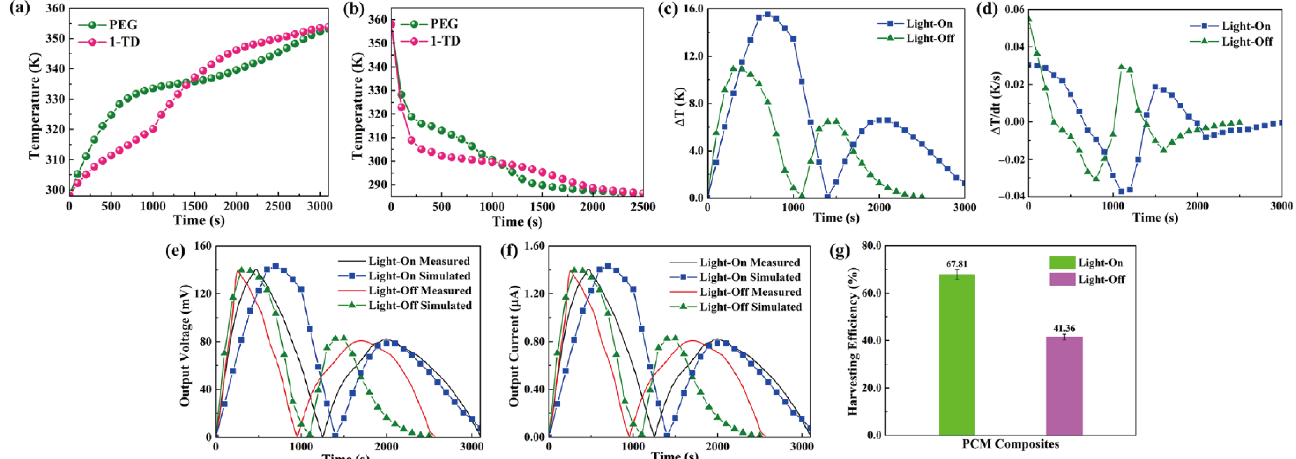
Figure 10. Multiple PCMs temperature profiles during the ( a ) light-on process and ( b ) light-off process. ( c ) Temperature difference upon the light-on/off process. ( d ) Change of temperature difference upon the light-on/off process. Experimental and simulation results of ( e ) the output voltage peaks upon the light-on/off process and ( f ) the output current peaks upon the light-on/off process. ( g ) Pyroelectric energy harvesting efficiencies during the light-on/off process.